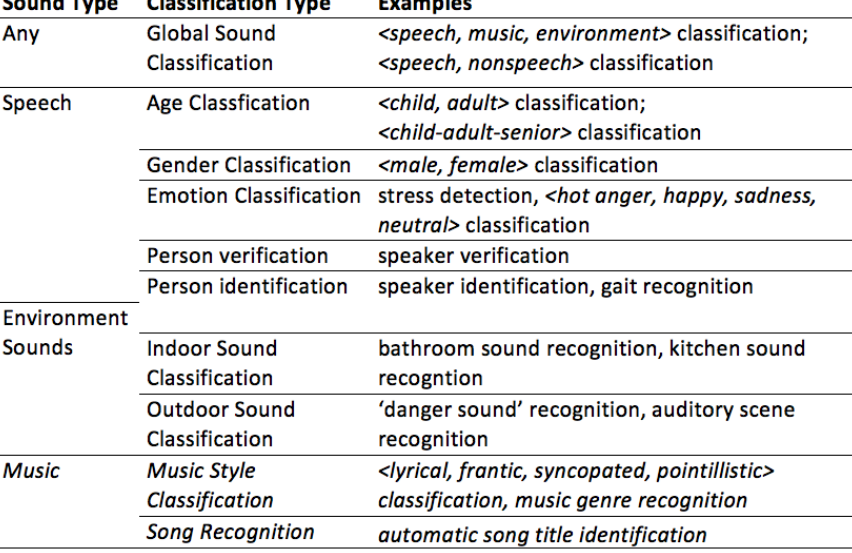
Figure 1. Classifications of sound